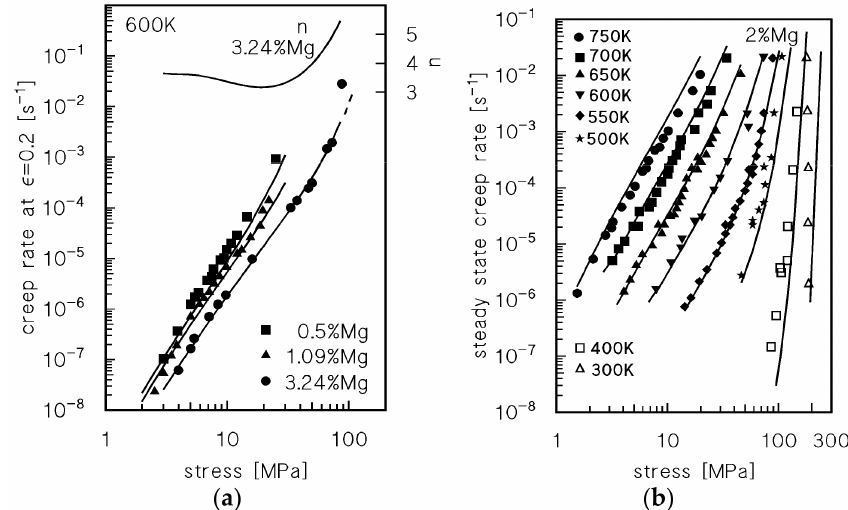
. ε / ∂ log σ for the alloy